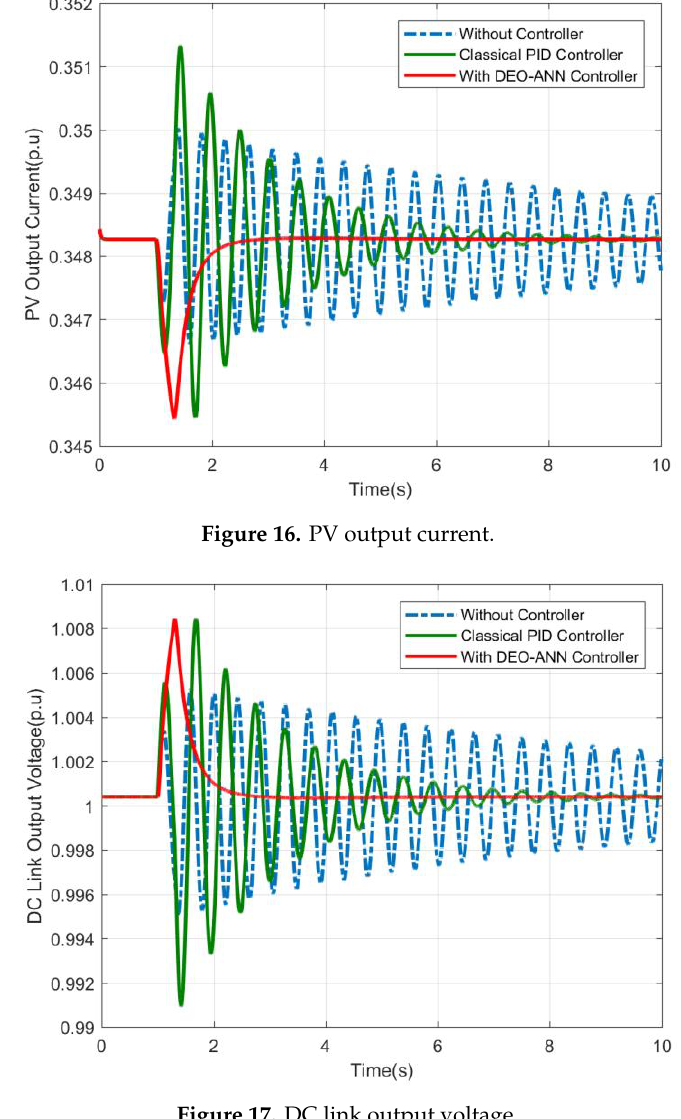
Figure 17. DC link output voltage.